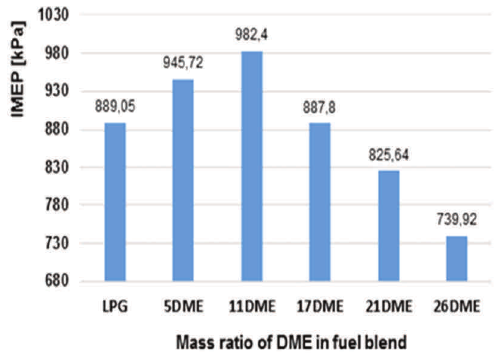
Fig. 1. IMEP for engine fueled by LPG-DME mixtures, at 2500 rpm; WOT and λ = 1.0 [2]